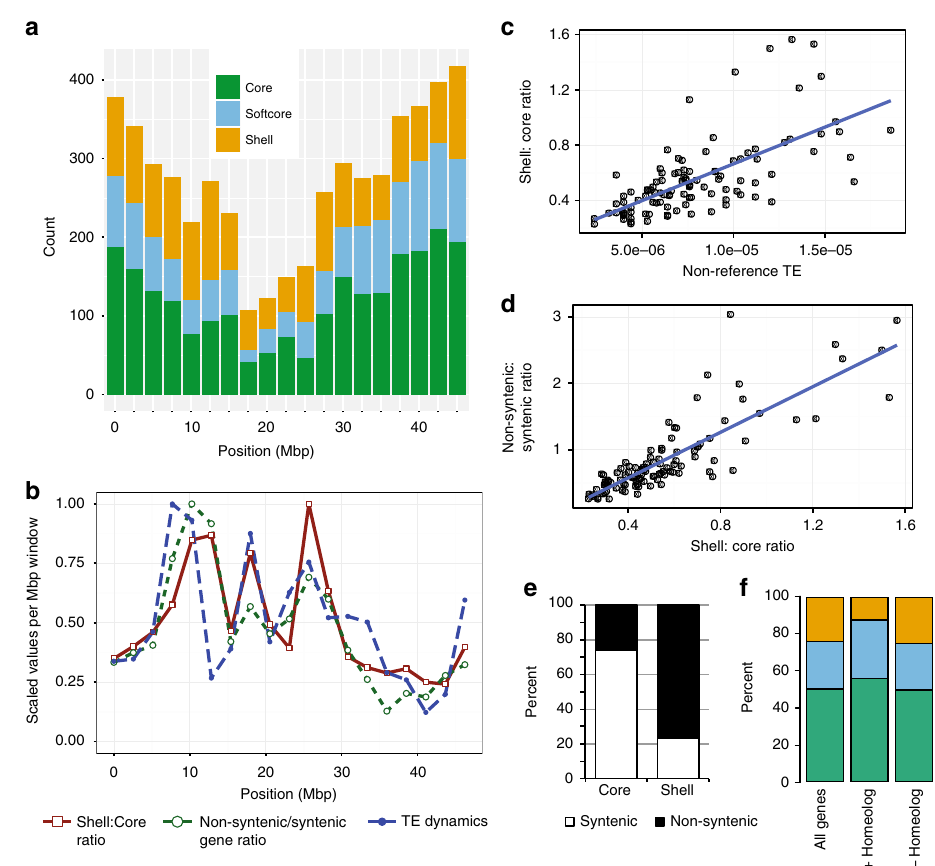
Fig. 5 Chromosomal characterization of pan-gene subsets. a Number of reference genes in respective pan-genome categories within 2.5 Mbp windows along chromosome 4. b Shell:Core gene ratio, non-syntenic:syntenic gene ratio (in comparison to rice, Oryza sativa ), and the number of reference TEs absent from other B . distachyon lines compared to the reference (a measure of TE dynamics), plotted for 2.5 Mbp non-overlapping windows along chromosome 4. Frequency of TE “ insertion ” relative to the reference genome shows a similar pattern as TE “ absence ” (Supplementary Fig. 9). c Intra- species TE insertion frequency vs. shell:core gene ratio within 2.5 Mbp genomic intervals. d Plot of non-syntenic:syntenic gene ratio vs. shell:core gene ratio. e Percent of core and shell genes in the reference genome that are/are not syntenic with the corresponding rice ortholog. f Fewer shell genes in the reference genome have a homeolog that was retained after the ancient grass whole-genome